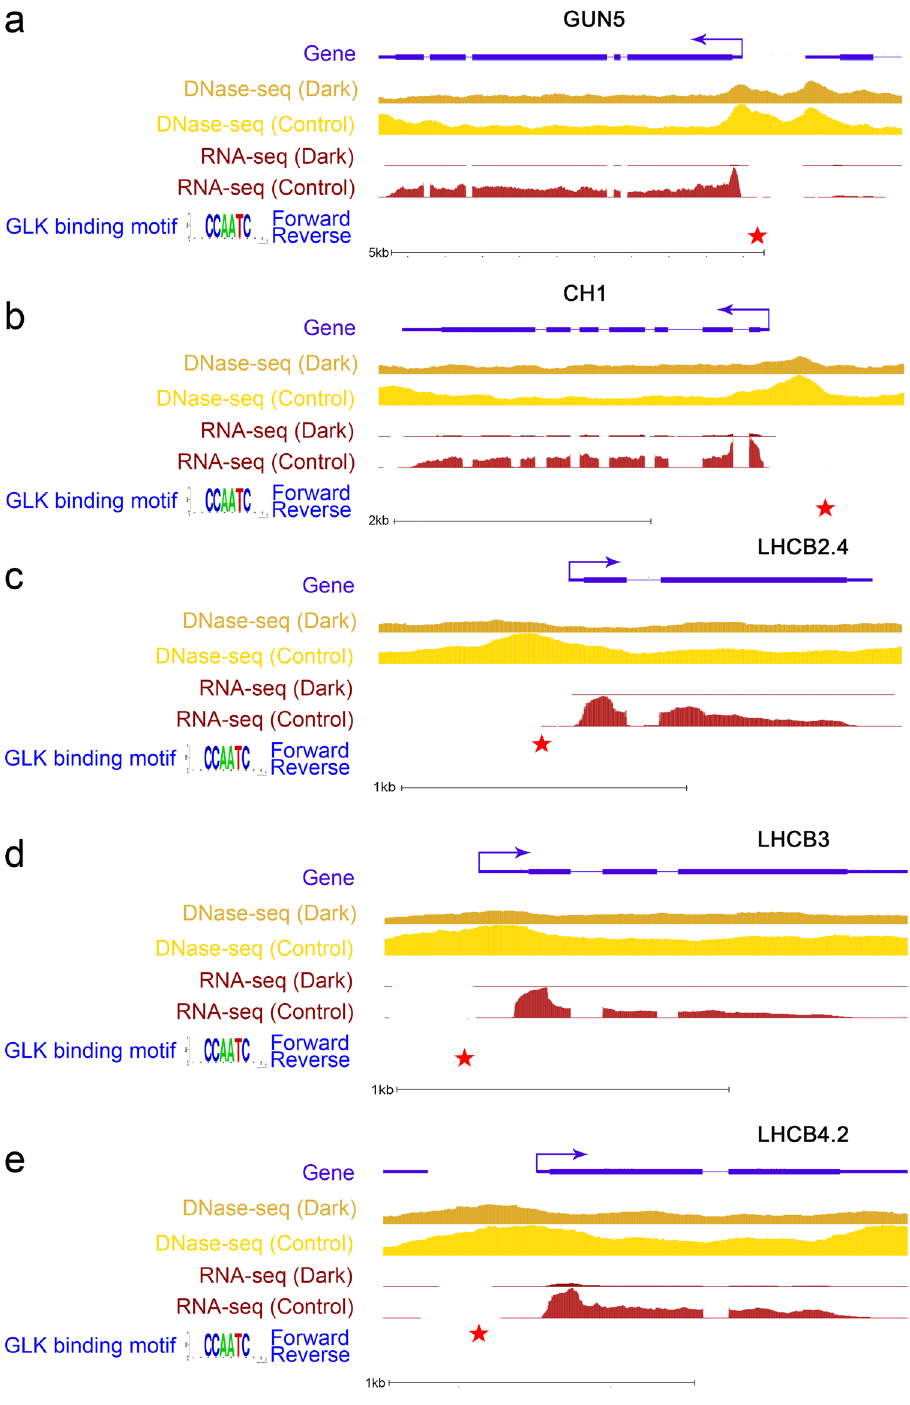
Figure 3. Selected genes associated with DHSs, expression and motifs in the UCSC genome browser. The gene models are shown in purple, with the direction marked by an arrow. The brown and yellow colors represent DHS signals under extended darkness and control condition, respectively. The red five-pointed stars represent the location of motifs. The dark red and light red colors represent expression signals under extended darkness and control condition, respectively. ( a ) GENOMES UNCOUPLED 5 (GUN5) encodes a magnesium chelatase involved in plastid-to-nucleus signal transduction. ( b ) CHLORINA 1 (CH1) encodes chlorophyllide a oxygenase which converts chlorophyllide a to chlorophyllide b by catalysing two successive hydroxylations at the 7-methyl group of chlorophyllide a. ( c ) LIGHT-HARVESTING CHLOROPHYLL B-BINDING 2 (LHCB2.4) belongs to the Lhc supergene family encodes the light-harvesting chlorophyll a/b-binding (LHC) proteins that constitute the antenna system of the photosynthetic apparatus. ( d ) LIGHT-HARVESTING CHLOROPHYLL B-BINDING PROTEIN 3 ( LHCB3 ) is a component of the main light-harvesting chlorophyll a/b-protein complex of Photosystem II (LHC II). ( e ) LIGHT HARVESTING COMPLEX PHOTOSYSTEM II ( LHCB4.2 ) is a protein involved in the light-harvesting complex of photosystem II. The mRNA has cell-to-cell